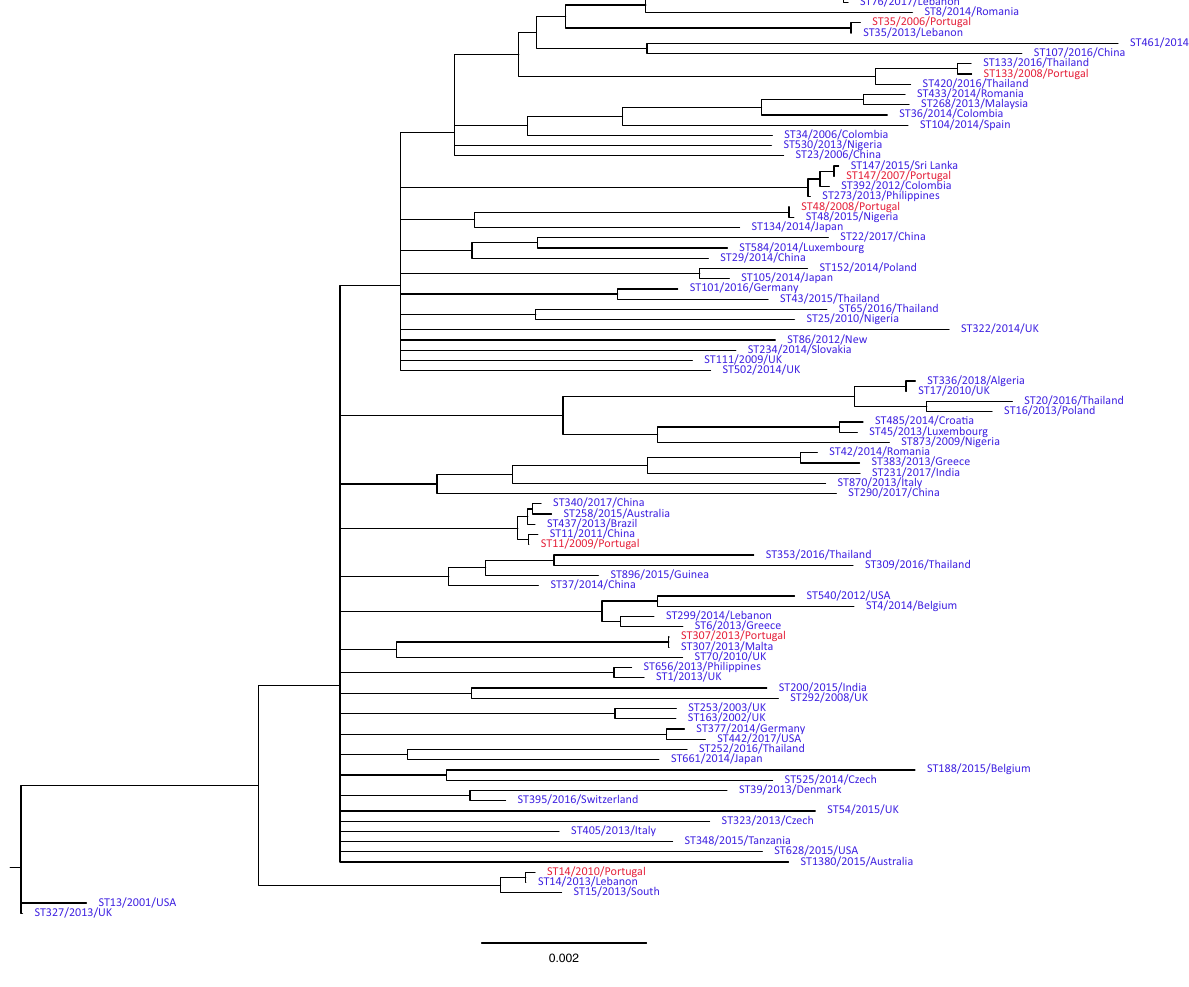
Figure 1. Unrooted maximum likelihood phylogenetic tree of common 83 Kp sequence types (blue) and the 8 isolates from our study (red). Edges with bootstrap support below 75 (based on 5000 bootstraps) were collapsed. Scale is nucleotide substitutions per site. Tip labels are sequence type, collection year and